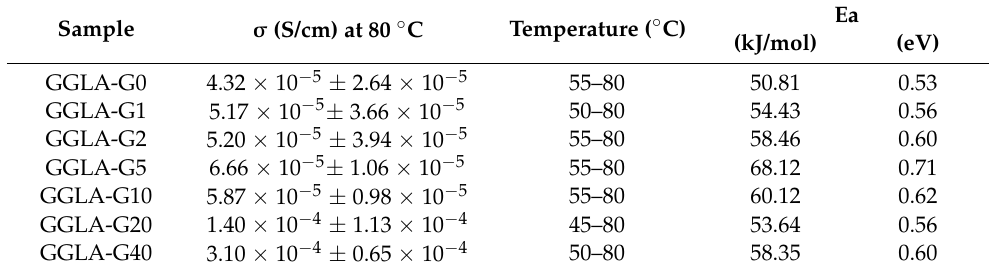
Table 2. Ionic conductivity and activation energy at high temperatures of GGLA